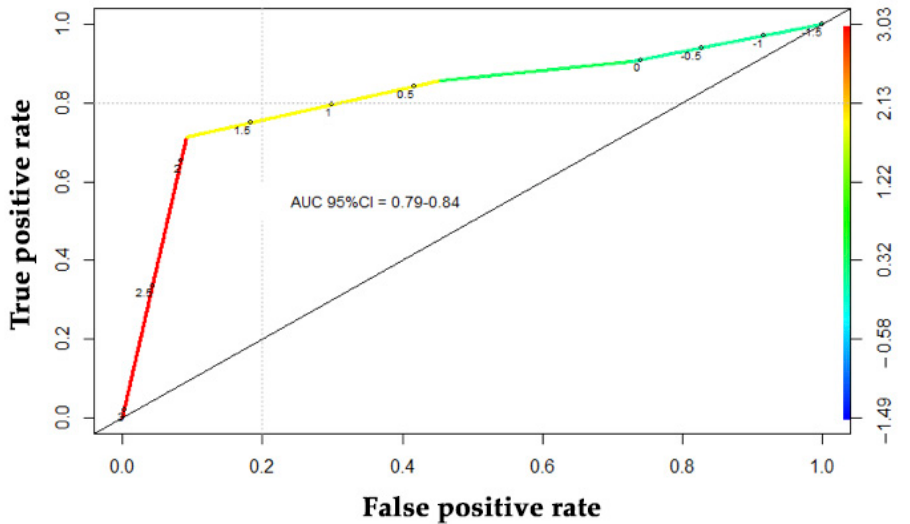
Figure 7. Prognostic value of the single-nucleotide polymorphism (SNP) rs7993418 as a pharmaco- logical marker of a poor response to regorafenib. ROC curve analysis of the SNP rs7993418 in the VEGFR1 gene indicates that the presence of this variant could be a useful biomarker for identifying poor responders to regorafenib, with an area under the curve (AUC) value of 7.9–8.4.